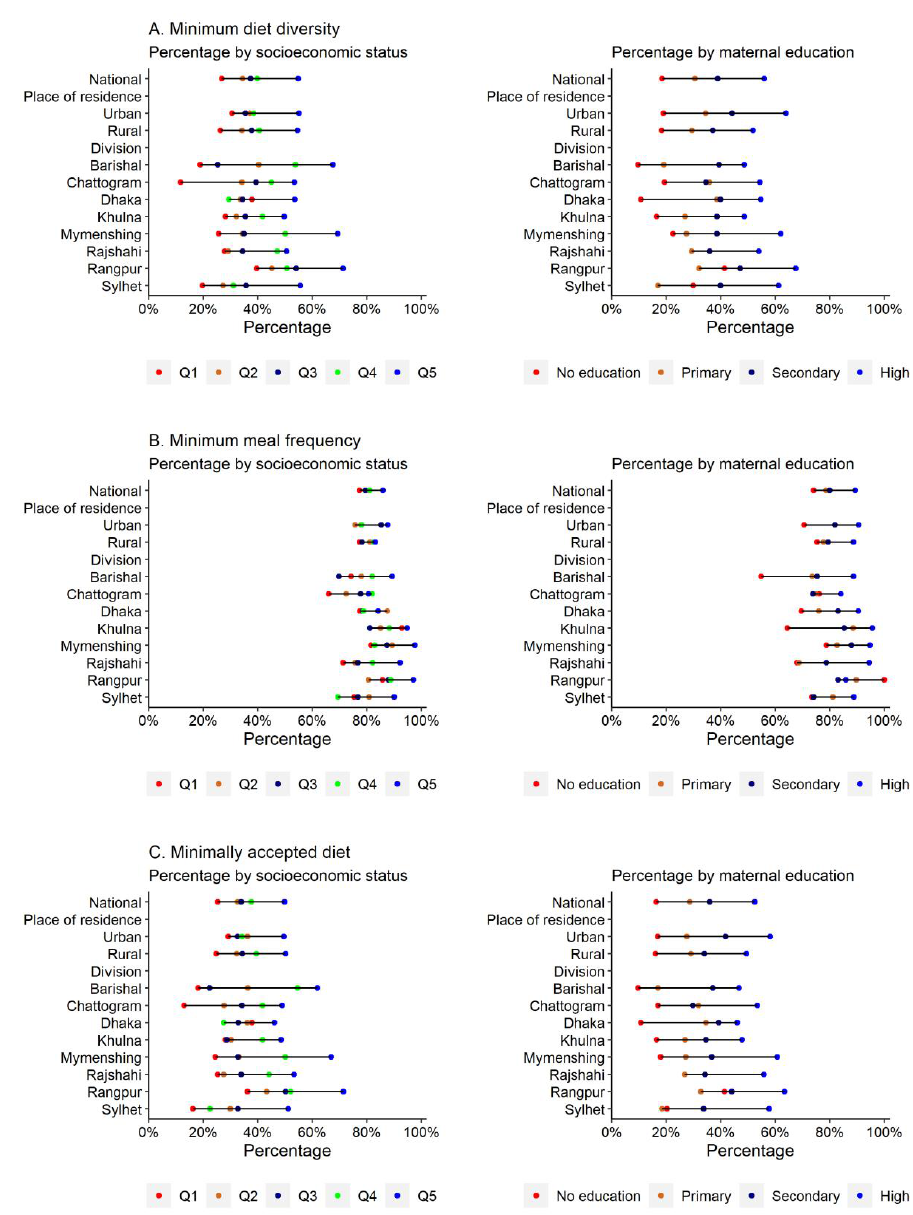
Figure 1. Prevalence of minimum diet diversity, minimum diet frequency and minimally accepted diet among Bangladeshi children aged 6–23 months by household socioeconomic status and maternal educational status.